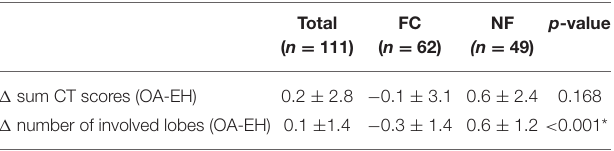
TABLE 4 | Comparison of 1 sum CT scores and 1 number of involved lung lobes between FC and NF groups.